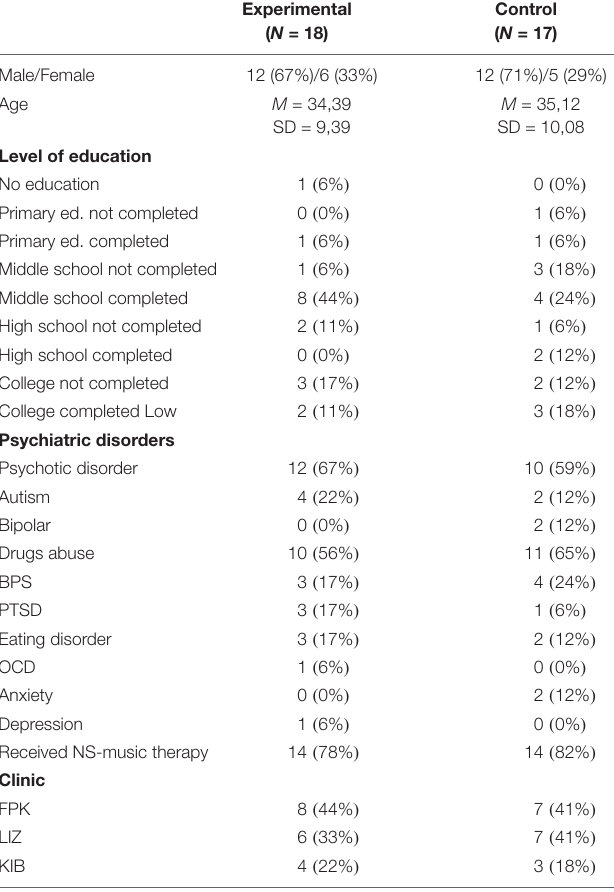
TABLE 1 | Participants’